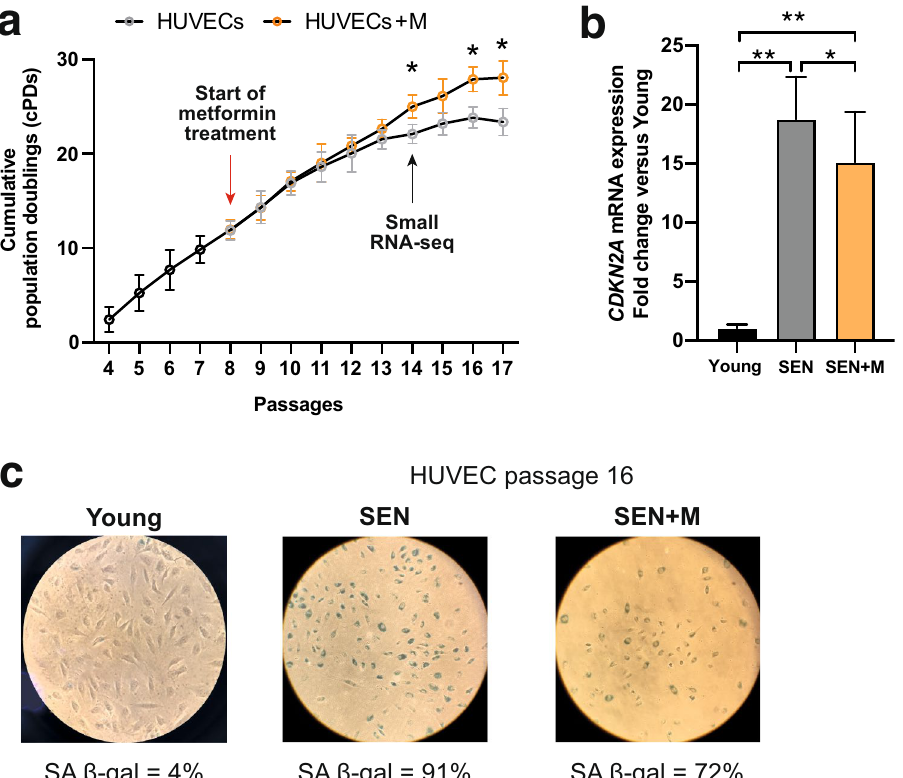
Figure 1. Characterization of replicative senescence in HUVECs. ( a ) Cumulative population doubling (cPD) curves. Metformin treatment was started after passage 7 (cPD = 9.83) and conducted at each medium replacement until complete growth arrest. ( b ) CDKN2A mRNA relative expression in young, SEN and SEN + M. Data are mean ± SD. *p < 0.05; **p < 0.01. ( c ) Representative positivity and quantification of the SA β-Gal staining in young, senescent (passage 16, SEN) and SEN HUVECs treated with metformin (SEN + M). HUVECs human umbilical vein endothelial cells, SA